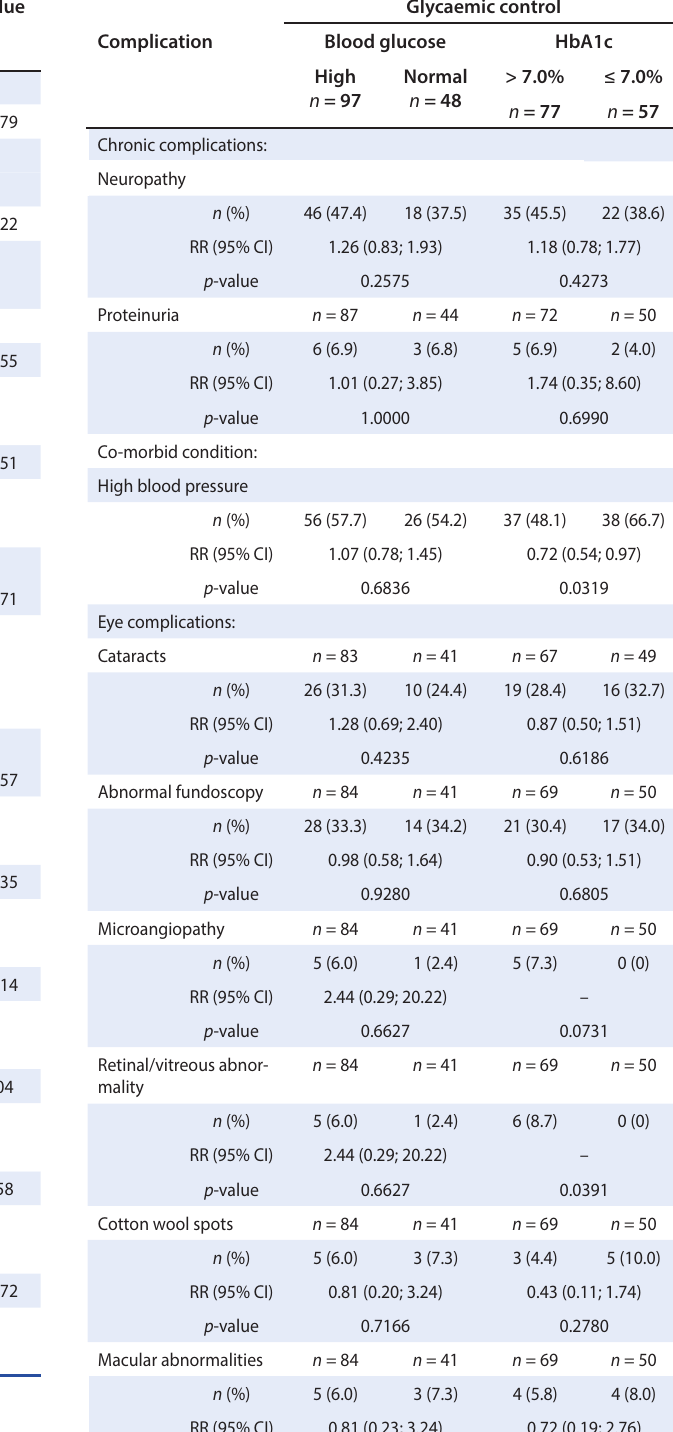
Table 3: Relationship between short-term and long-term glycaemic control and diabetes mellitus (DM)